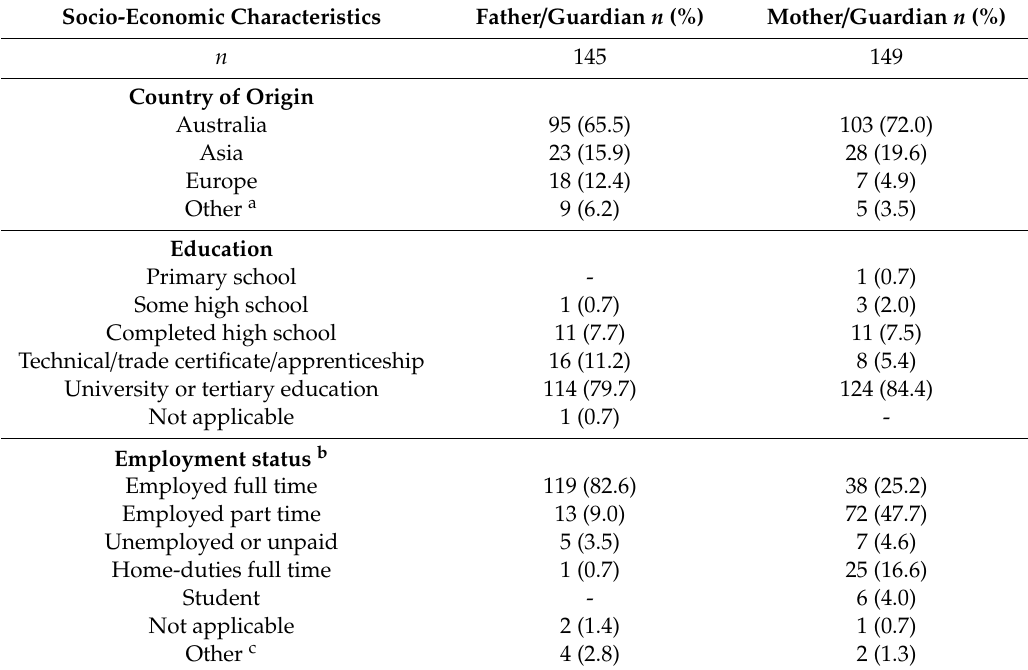
Table 1. Participants’ parental country of origin, education, occupation and income (count